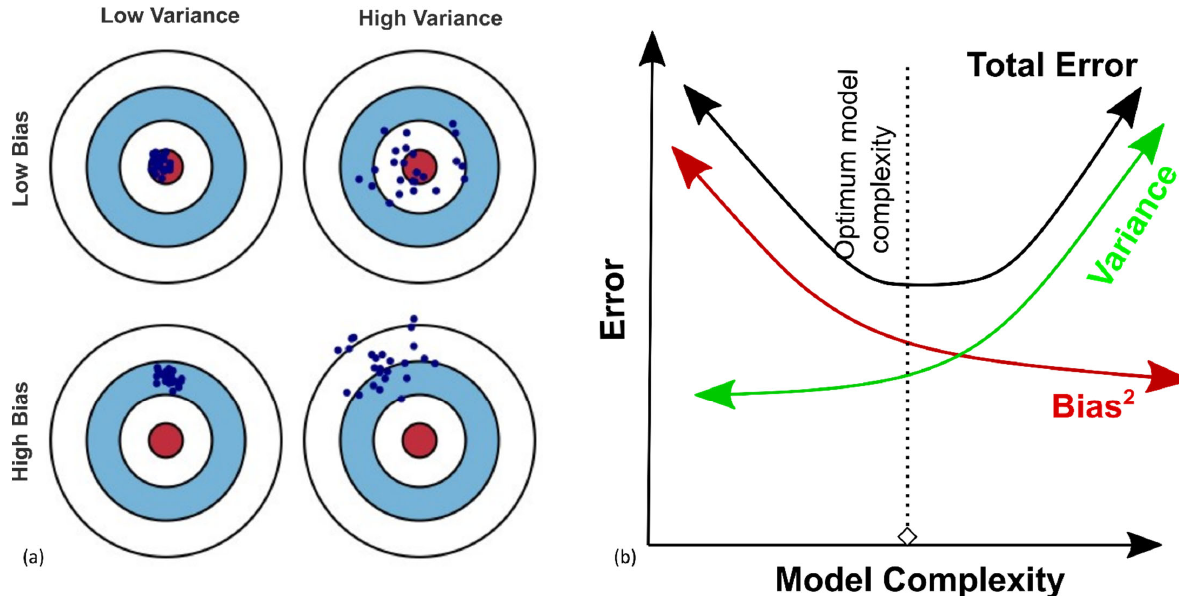
Figure 3. Workflow for TOC prediction with the ensemble learning approach. The process starts with the accumulation of input data sets and their QA/QC followed by ensemble learning implementation in several steps as shown by a red dotted arrow.